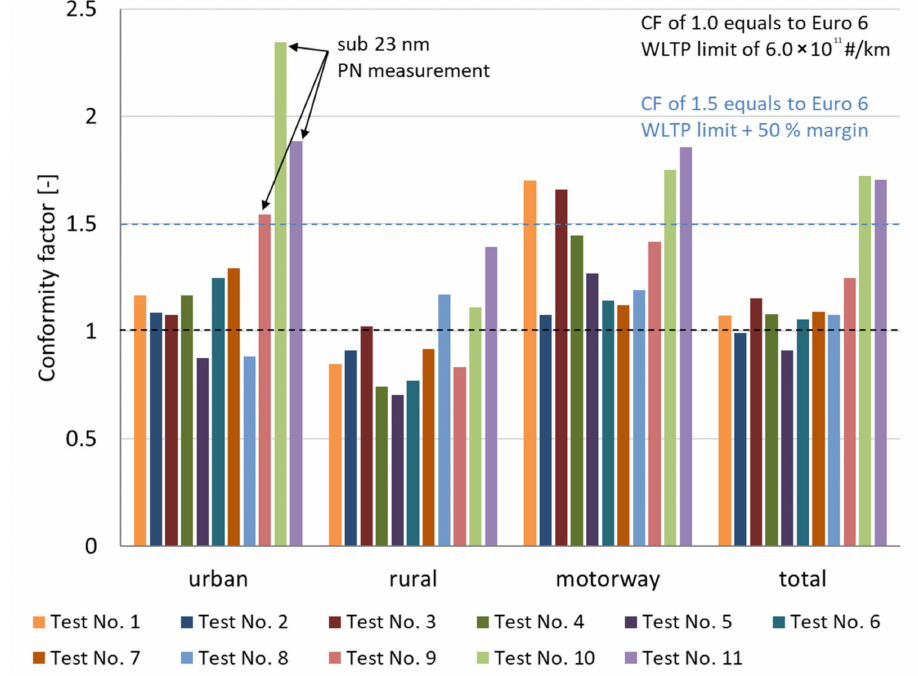
Figure 13. Conformity factors (CFs) for PN emissions of the performed real-world driving tests with the studied